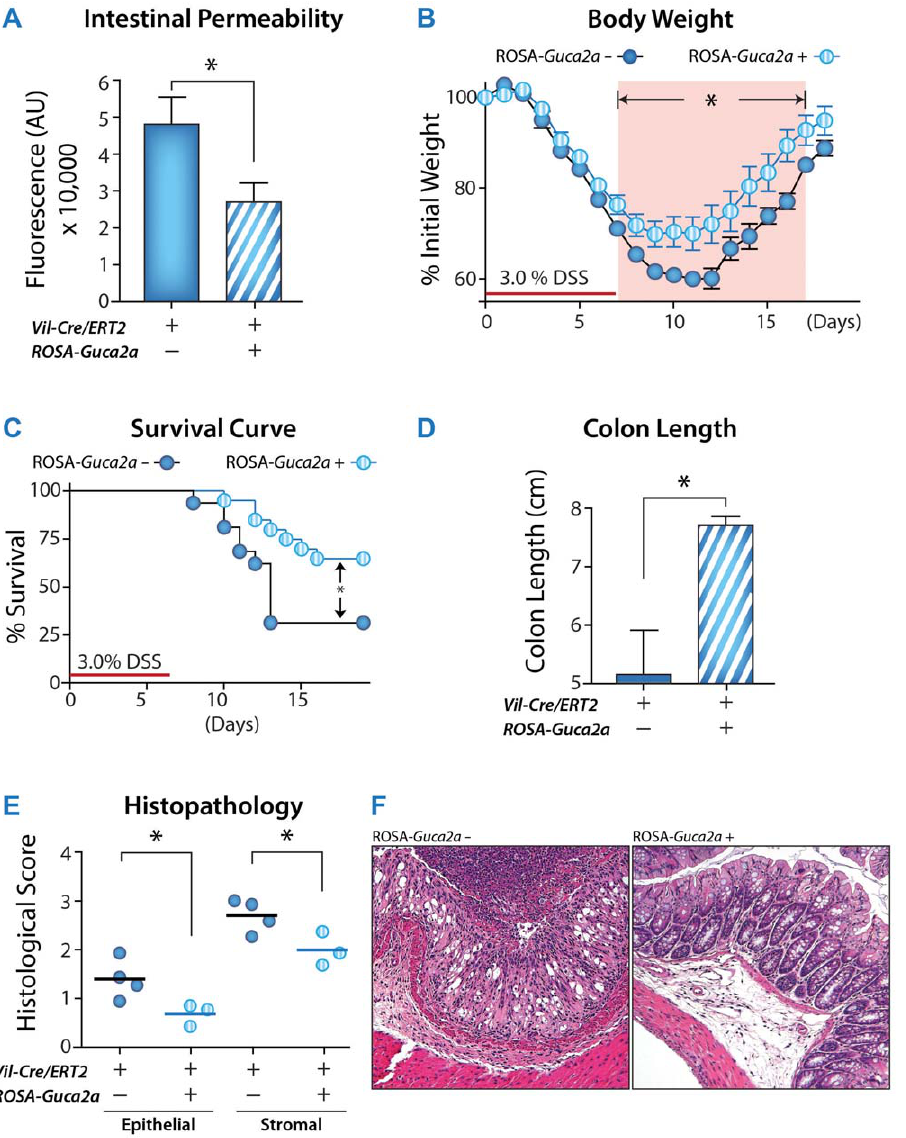
Figure 4. GUCY2C ligand supplementation decreases intestinal permeability and susceptibility to DSS-induced colitis. C57B6 female mice were administered control peptide (CP) or ST to examine the effect of GUCY2C activation on intestinal permeability after 14 d of oral ligand supplementation. ( A ) Serum fluorescence was analyzed 90 min after FITC-dextran gavage (n=21) following 6 d of ligand supplementation. ( B, C ) Following 14 d of ST pre-conditioning, 3.5% DSS was administrated for 7 d to induce colitis which was quantified by ( B ) body weight and ( C ) survival. Data represent one of two independent experiments. Severity of colitis was quantified by ( D ) colon length, measured on day 10 (3 d post-DSS exposure), and gross anatomic analysis of colons from ST-, compared to CP-, preconditioned mice demonstrated normal stool formation (n=21) and ( E ) histological score on day 10. Each point represents one mouse. ( F ) Representative H&E colon sections (20 6 ). *, p , 0.05, **, p , 0.01.